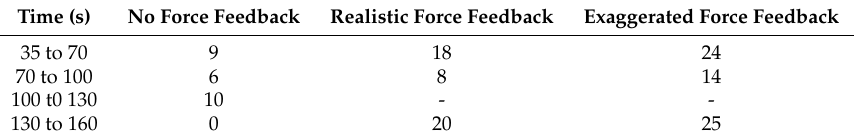
Table 9. Time elapsed in tolerance band at different time intervals.